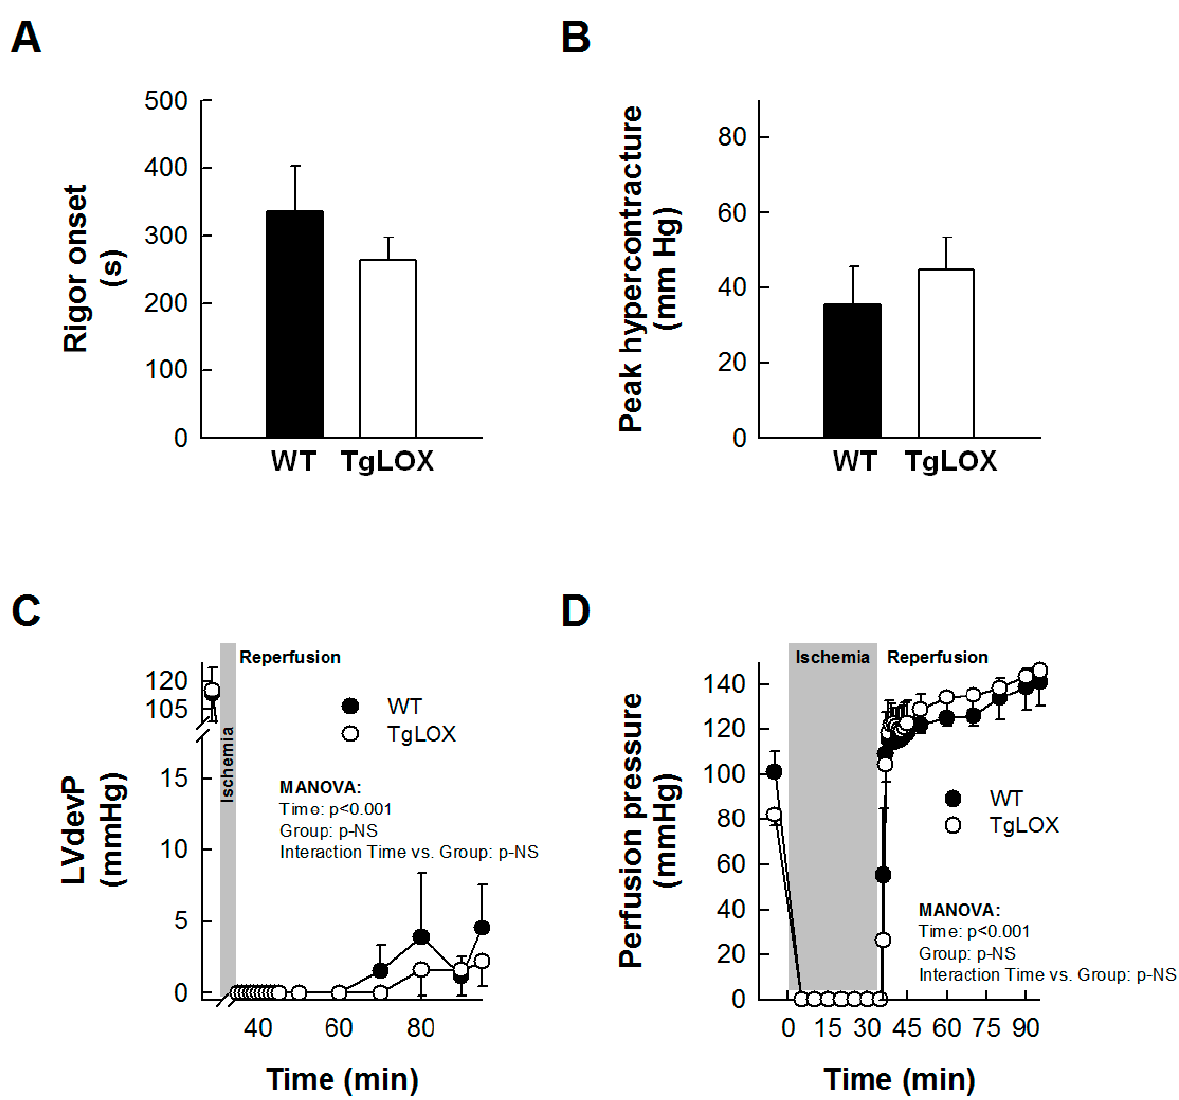
Figure 2. Impact of LOX transgenesis on rigor onset, peak hypercontracture, and functional recovery in isolated mice hearts. Rigor onset during ischemia ( A ) and peak hypercontracture ( B ) during initial reperfusion in isolated wild-type (WT) and TgLOX mice hearts submitted to global ischemia-reperfusion ( n = 5/group). No significant differences between both groups were observed (Student’s t -test). ( C , D ) show functional recovery during reperfusion (LVdevP, ( n = 4/group)) ( C ) and changes in perfusion pressure ( D ) ( n = 5/group) in isolated hearts from both groups. No significant differences between both groups were observed (repeated measures ANOVA and Dunnett’s tests). Data are expressed as mean ±